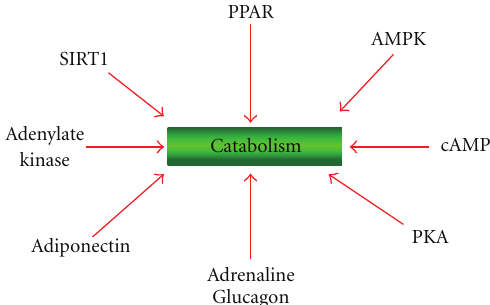
Figure 4: Enzymes, hormones and transcription factors involved in